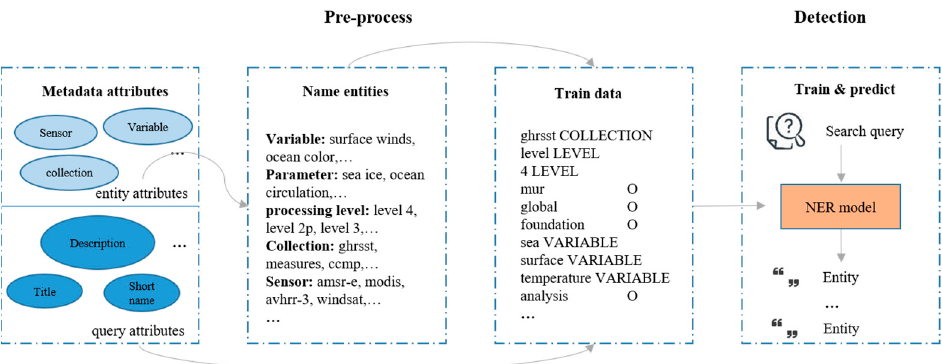
Figure 5. Workflow of named entity recognition (NER) train data preparation, train, and prediction.